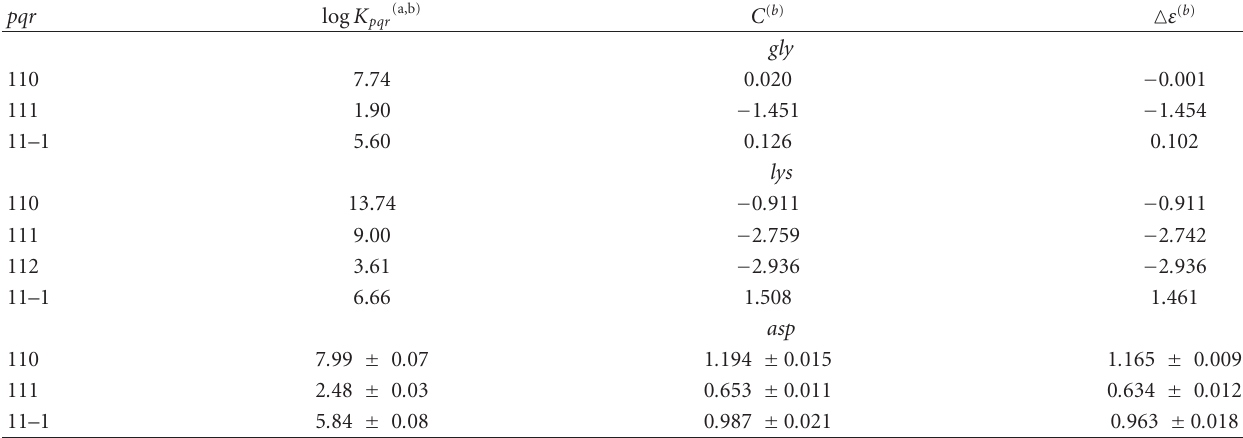
Table 5: Empirical parameters of (5) for the dependence of stability constants of dimethyltin(IV)/aminoacid species on ionic strength in the molar or molal concentration scales, in NaCl aq and t = 25 ◦ C.